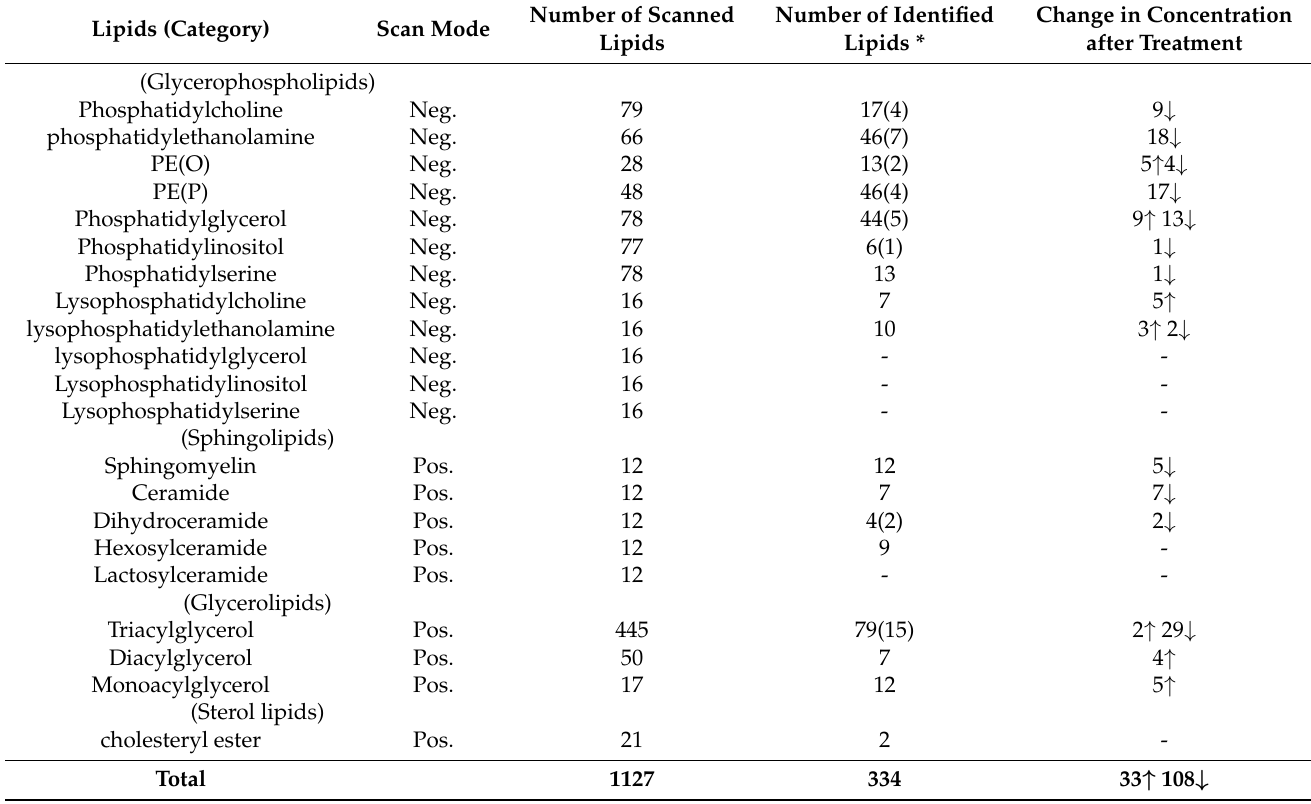
Number of Scanned Number of Identified Change in Concentration Lipids Lipids * after Treatment